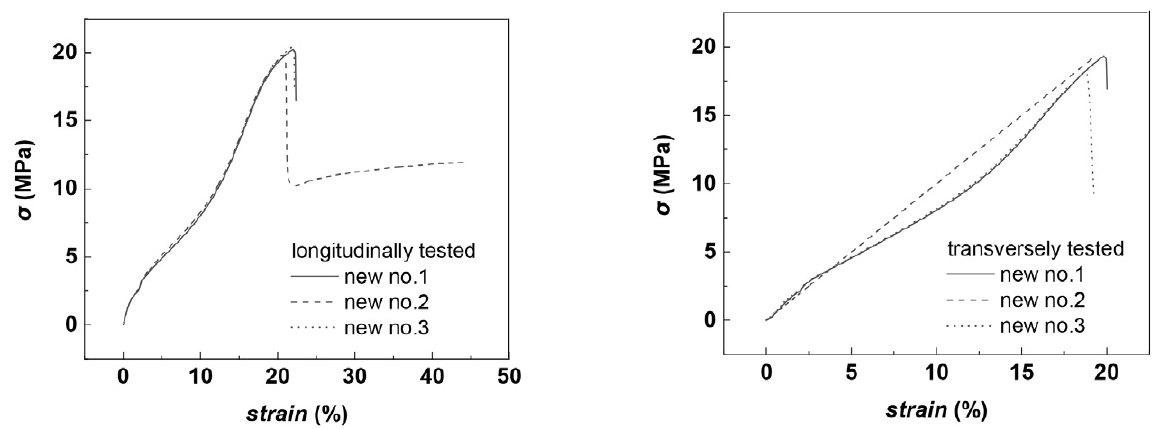
Figure 2. Tensile strength and elongation at break (load/strain curves) for new plasticized PVC membrane samples tested longitudinal (left) and transverse (right) directions at conditions: T = 393.15 ± 2 K, RH (relative humidity) = 50 ± 5 %.